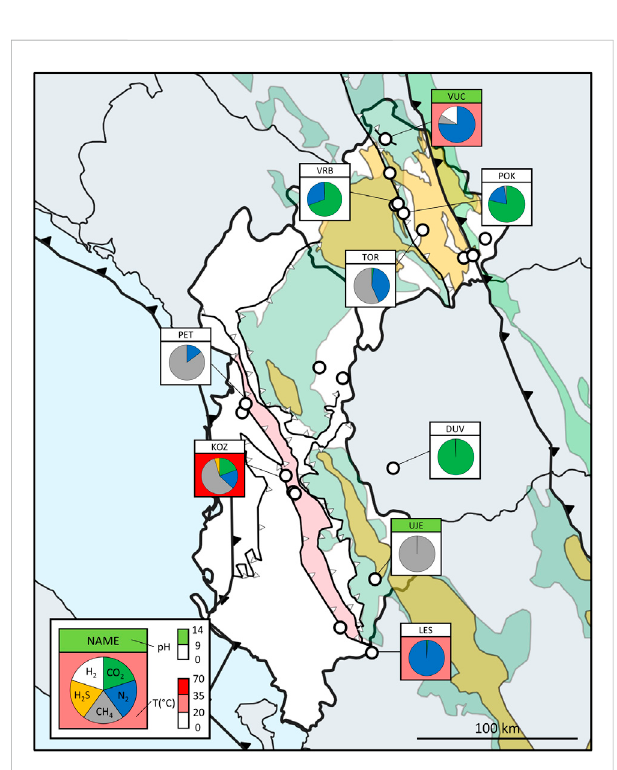
Gas composition of the different gas seeps with the temperature and pH of the associated water represented on the map shown in Figure 1C. The white points represent the studied gas